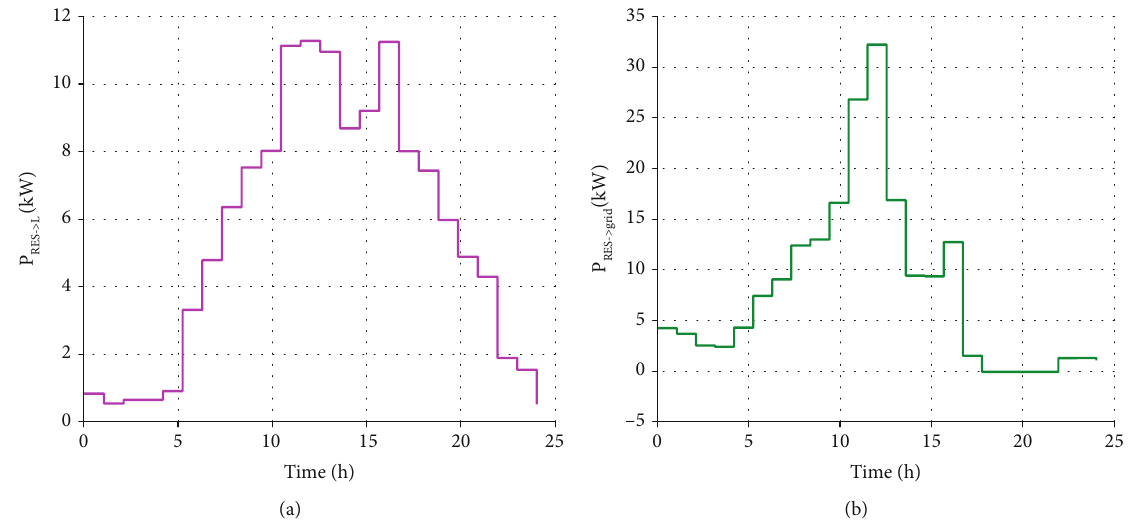
Figure 24: (a, b) Discharged power from RES to the load and grid by the FMINCON algorithm, respectively. Table 8: Optimal cost and cost saving